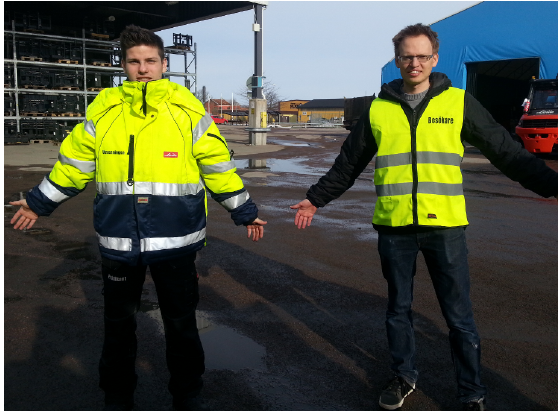
Figure 1. The two types of reflective safety garments used throughout the experiments: ANSI/ISEA safety class 2 vest with reflectors only in the body area ( right ) and safety class 3 jacket with additional reflectors in the shoulder and arm area ( left